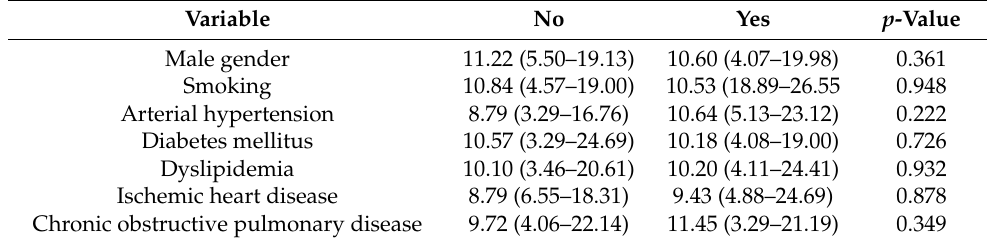
Table 2. Plasma galectin-3 concentrations (ng/mL) in PAD patients segregated according to the presence or absence of the selected clinical variables.